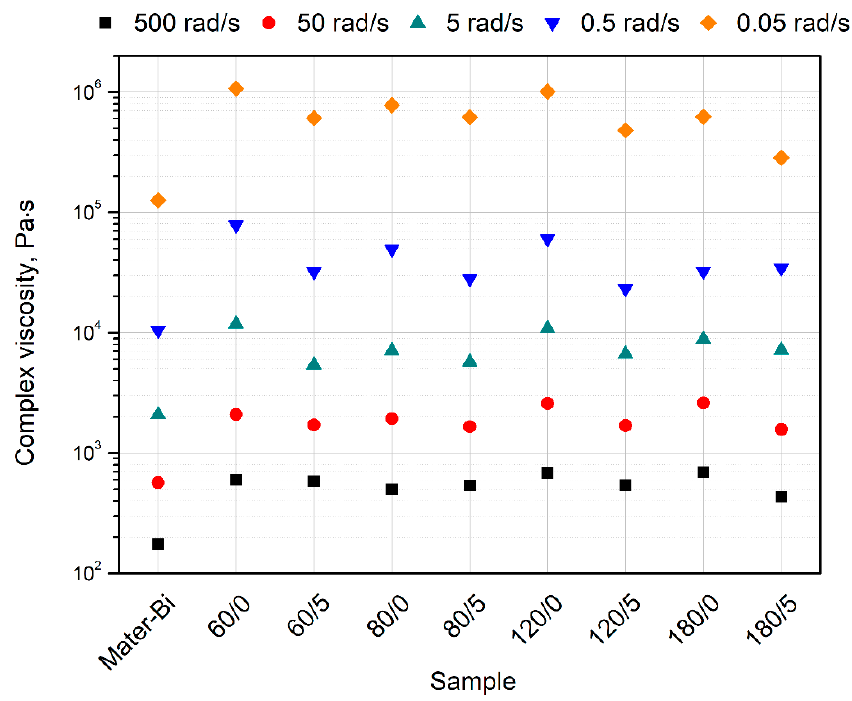
Figure 8. Values of complex viscosity of prepared materials at selected angular frequencies.